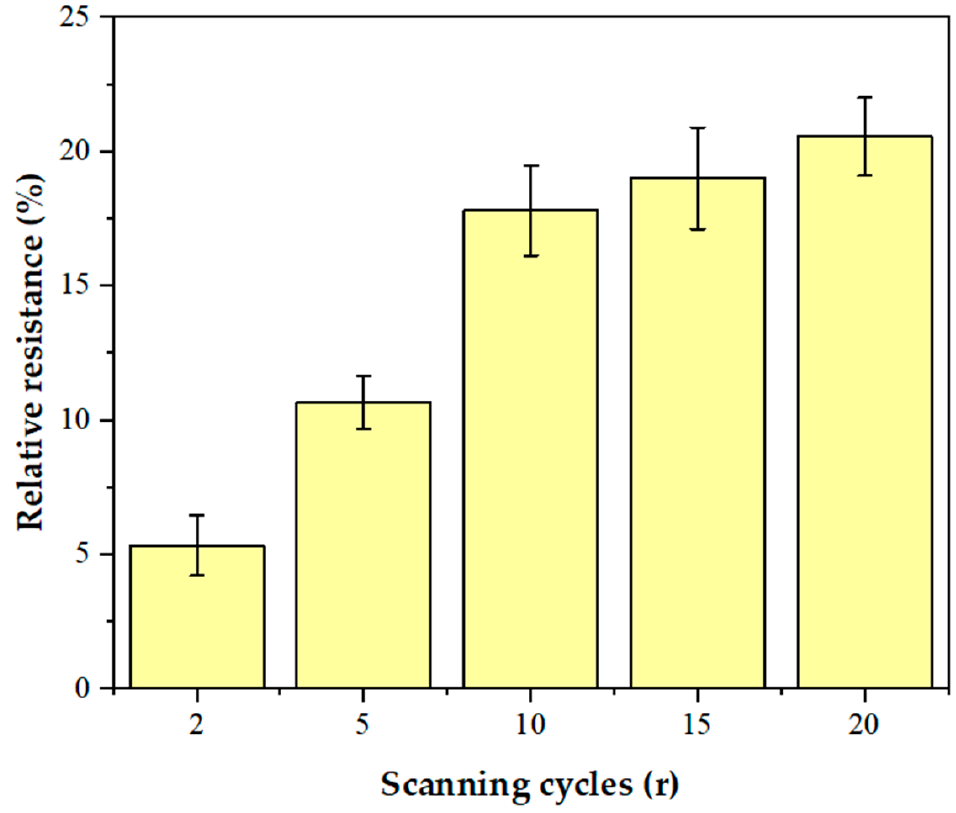
Figure 8. The relative resistance of GCE/NGR/AuNPs/Sub-DNAzyme duplex electrodeposition of AuNPs with different scanning cycles (2 r, 5 r, 10 r, 15 r, and 20 r) in 100 µ M Ca 2+ solution (The error bars were determined in three duplicates).